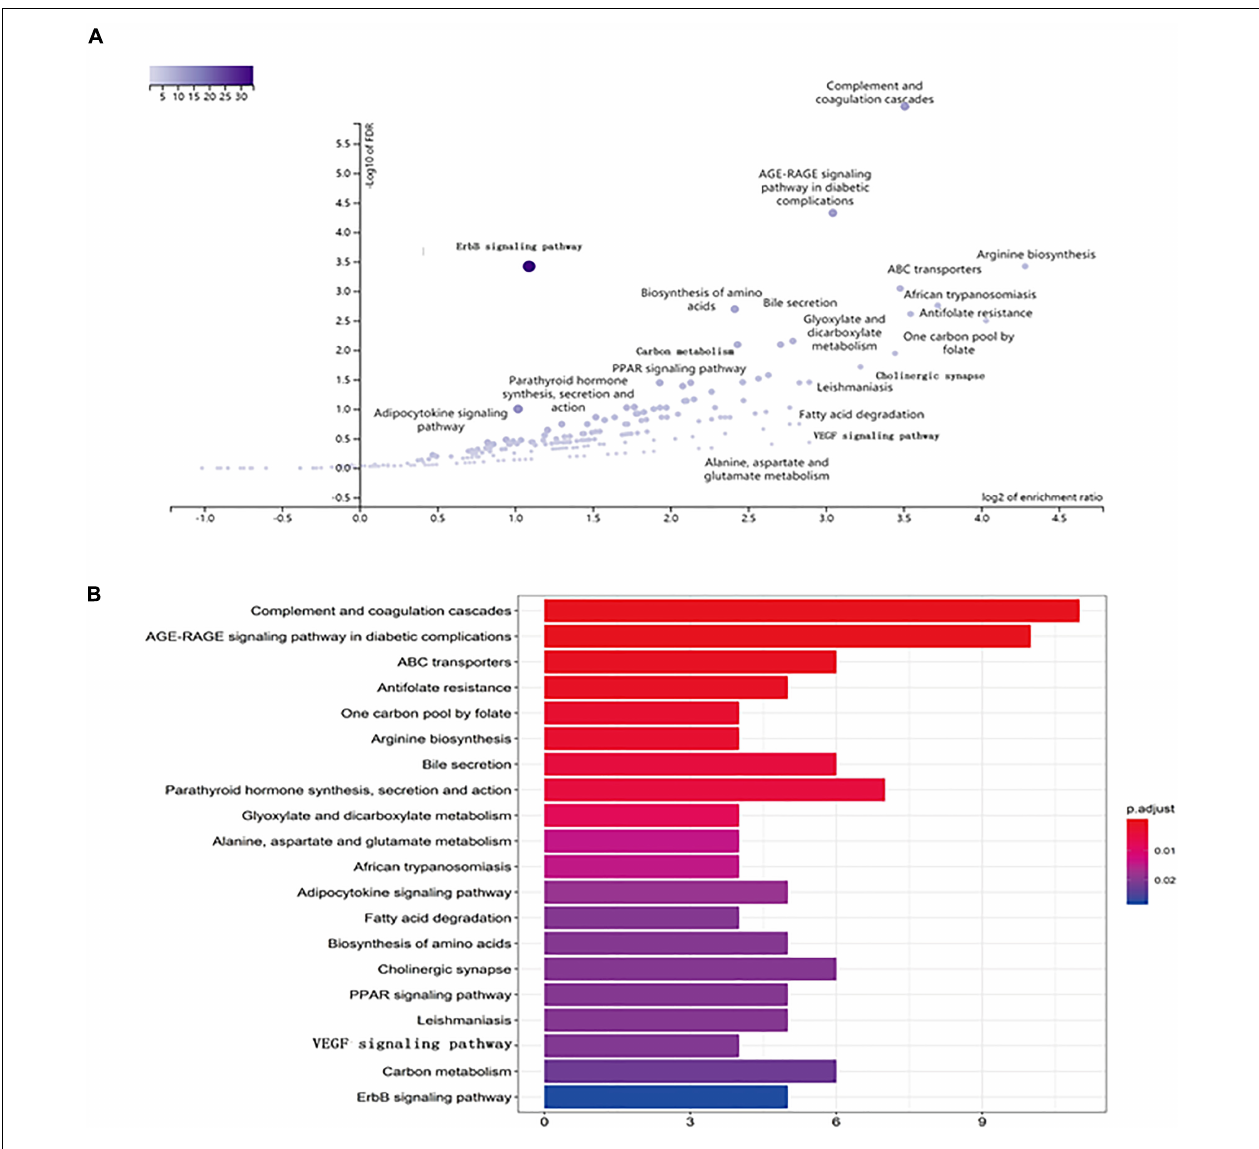
FIGURE 7 | KEGG pathway enrichment of candidate targets of EJSW against ITP. (A) The volcano plot of KEGG pathway enrichment. (B) The top 20 pathways with p < 0.05 were